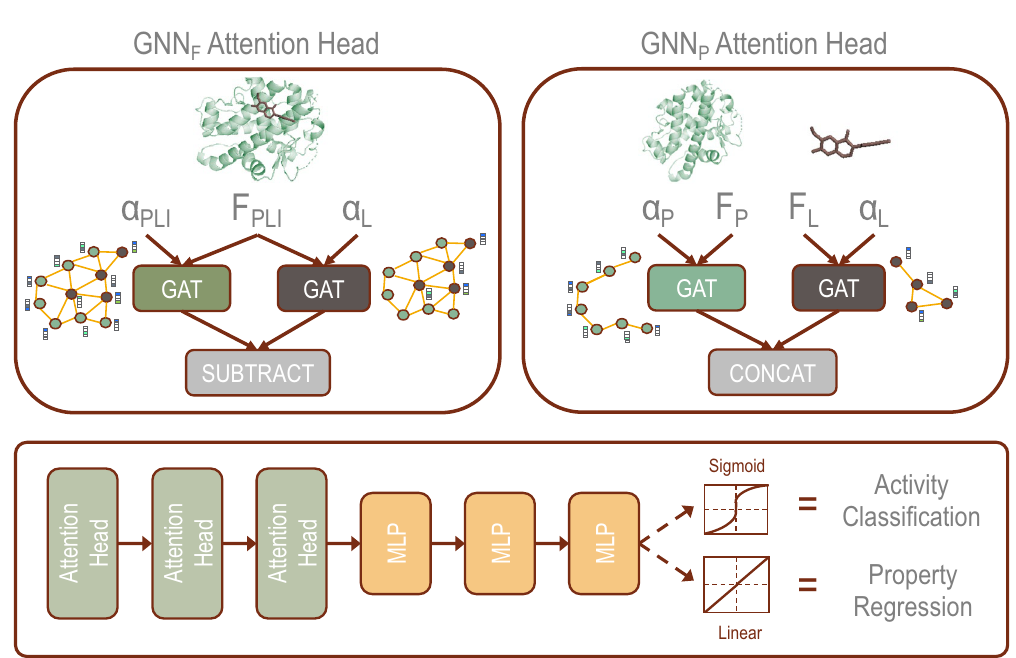
Figure 1. Schematic showing the prediction logic implemented in our GNN models. The two models differ based on the applied attention head. GNN F uses the PLI obtained from docking simulations to create a combined feature and adjacency matrix. In GNN P , the features for the ligand and target protein are coded separately alongside their corresponding adjacency matrices. The output from the attention head is passed through a series of MLP that can be tuned for activity classification through application of the sigmoid activation function and binary cross-entropy loss function or property regression through application of the linear activation function and mean squared error loss